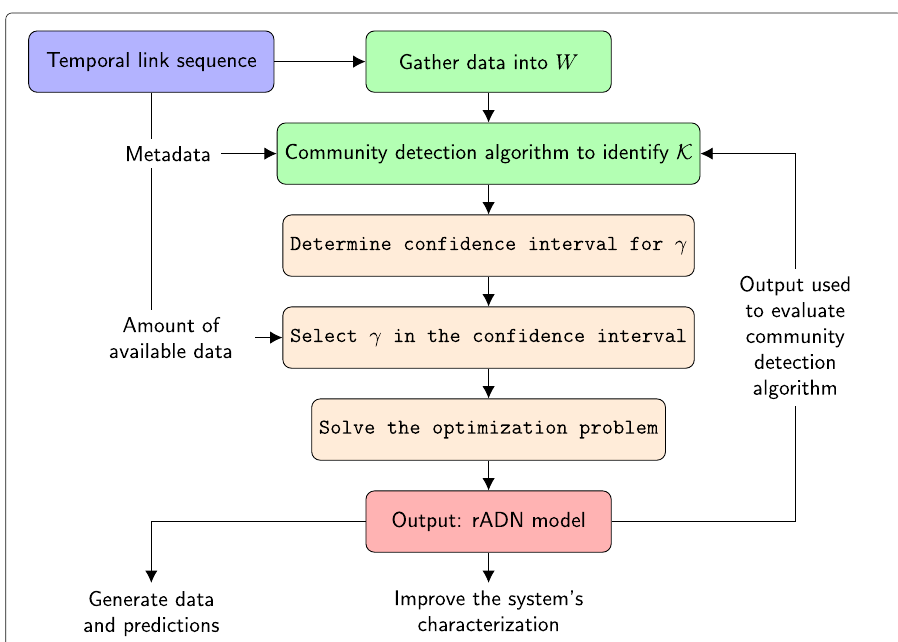
Fig. 4 Flow chart of the parameter identification method. Data on the temporal connections are gathered into the weighted adjacency matrix W of the integrated network. Then, a community detection algorithm is used to preliminary detect a set of communities. The community detection algorithm may be enriched by available metadata. A confidence interval for the community belief is then computed and the parameter γ is selected within this interval, on the basis the available data. Finally, fixed γ , the model parameters are identified through the solution of an optimization problem. A rADN model statistically compatible with the available data is eventually derived. The output of such a model can be used to assess and improve the performance of existing community detection algorithms or, on its own, to enrich the characterization of the system and to generate data and predictions that are compatible with the available